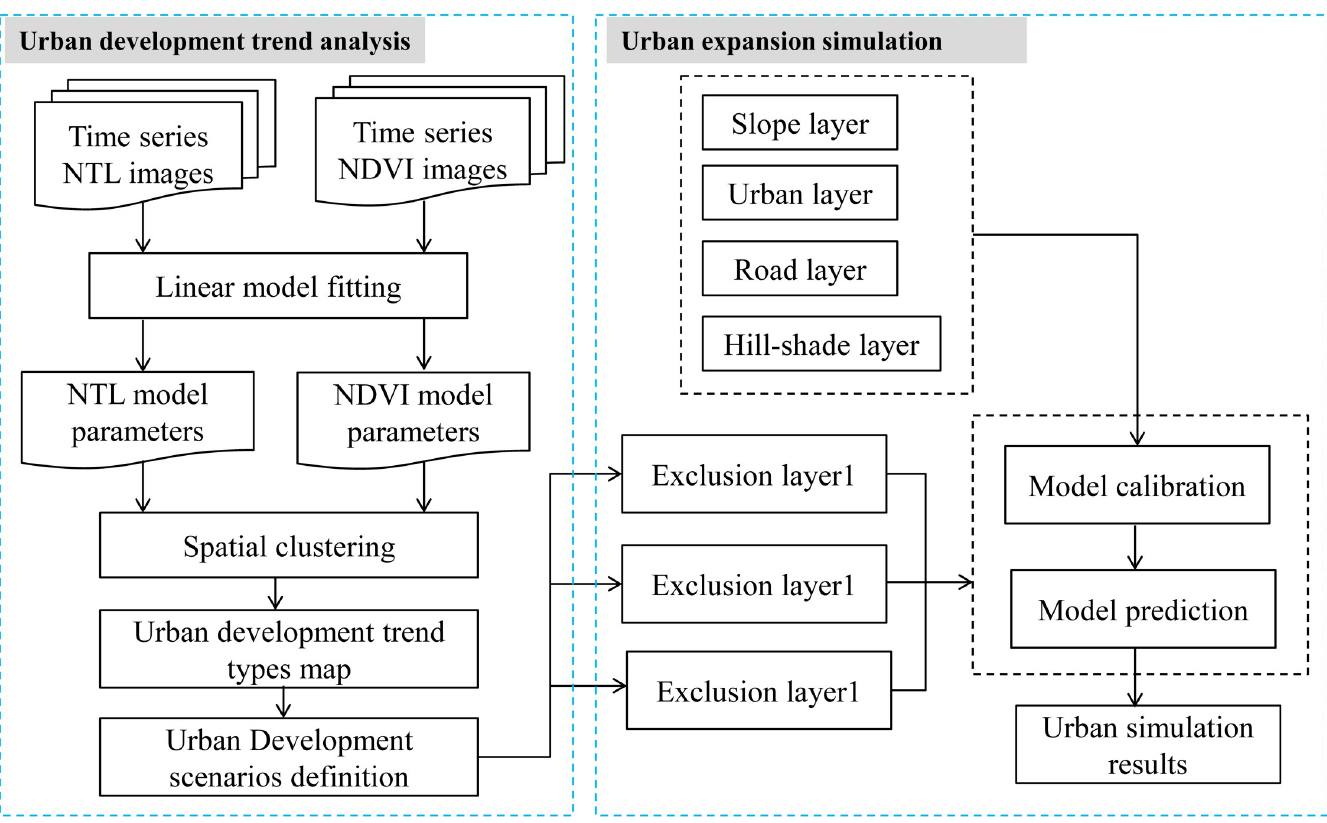
Fig 2. The flowchart of this